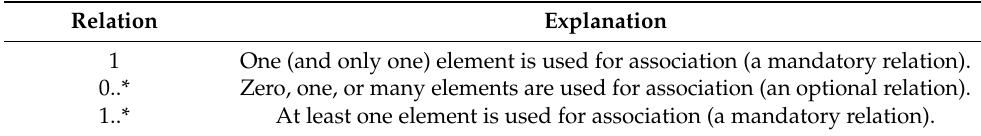
Table 2. Relation cardinalities used in the unified data